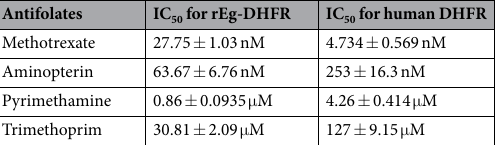
Table 1. IC 50 values for inhibition of rEg-DHFR and human dihydrofolate reductase (DHFR) by various antifolates. K m and V max were determined for the substrate (DHF) in triplicate for rEg-DHFR and human DHFR. The data are expressed as the mean ± standard deviation